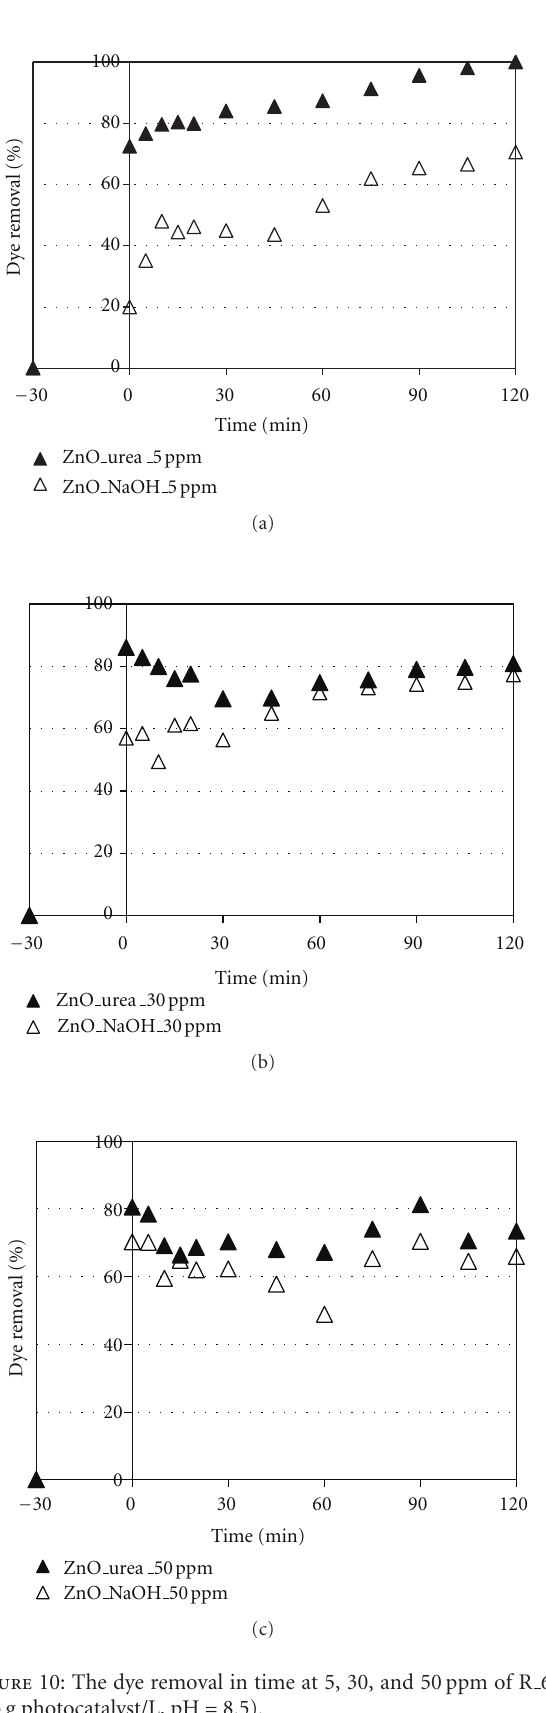
Figure 10: The dye removal in time at 5, 30, and 50 ppm of R 6G (0.3g photocatalyst/L, pH = 8.5).